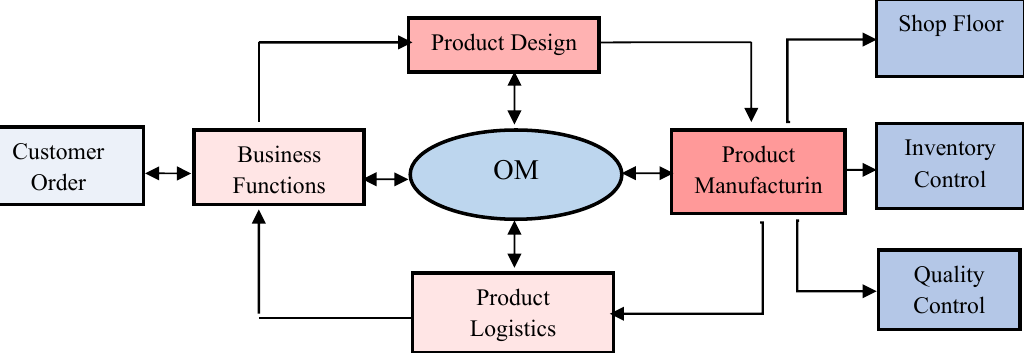
Fig. 1. Pictorial representation of NGOM cycle